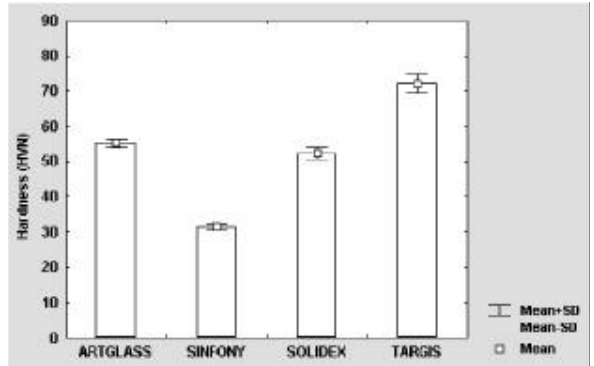
FIGURE 1 - Box and Whisker Plot representation of microhardness values (HVN) for each indirect composite